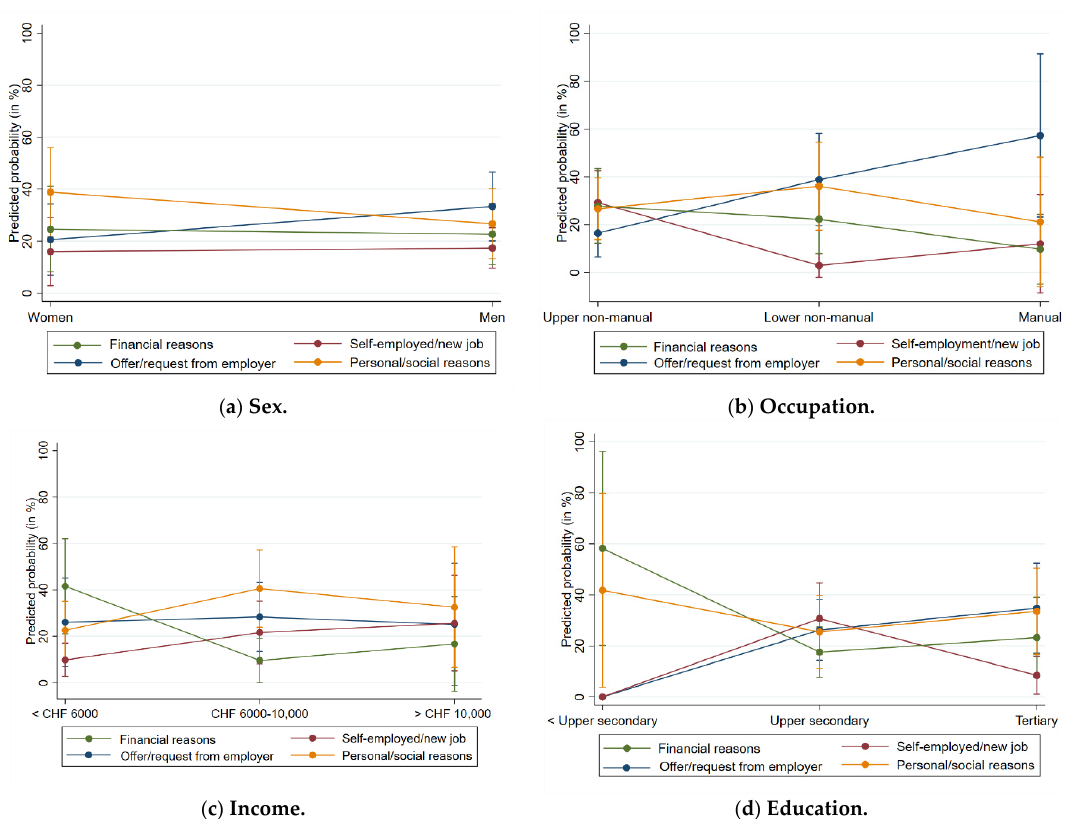
Figure 1. ( a – d ) Predicted probabilities and 95% confidence intervals, based on a multinomial logistic regression on reason for working beyond the SRA.